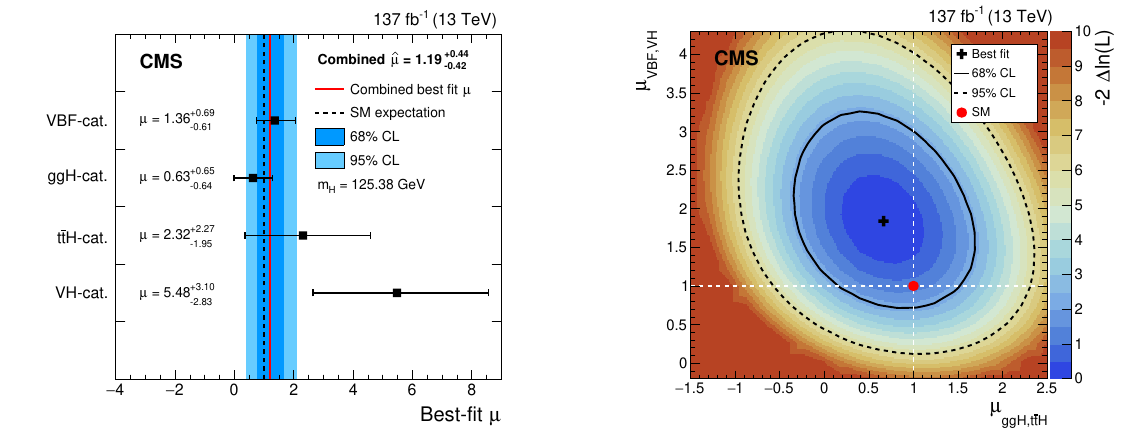
Figure 11 . Left: signal strength modifiers measured for m = 125 . 38 GeV in each production cate- H gory (black points) are compared to the result of the combined fit (solid red line) and the SM expec- tation (dashed grey line). Right: scan of the profiled likelihood ratio as a function of µ and ggH , ttH µ with the corresponding 1 σ and 2 σ uncertainty contours. The black cross indicates the best VBF , VH fit values (ˆ µ , ˆ µ ) = (0 . 66 , 1 . 84) , while the red circle represents the SM VBF , VH ggH , ttH